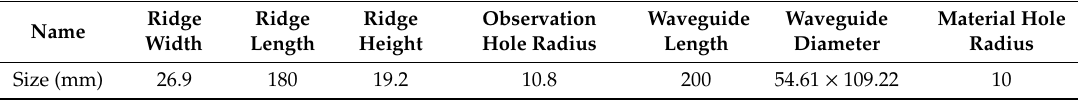
Figure 1. Schematic of ridge waveguide. Table 1. Dimensions of the ridged waveguide.